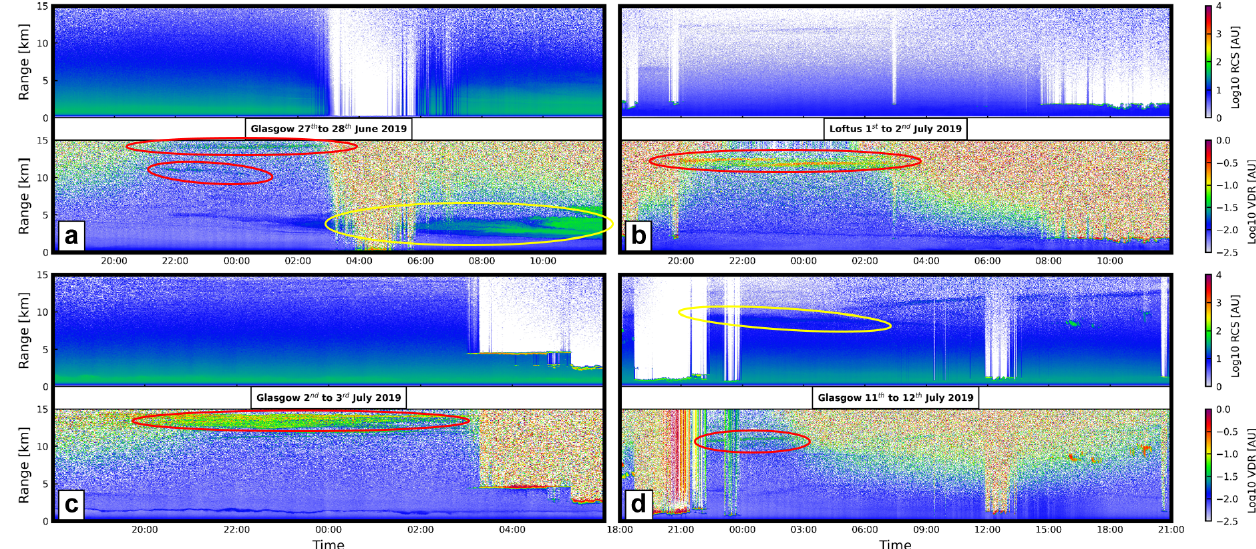
Figure 11. Lidar data from the Met Office lidar sites at Glasgow and Loftus on dates indicated in each axis pair (a) , (b) , (c) and (d) . The upper panel of each pair shows the range-corrected signal [AU], and the lower panel shows the volume depolarisation ratio (VDR) [%].